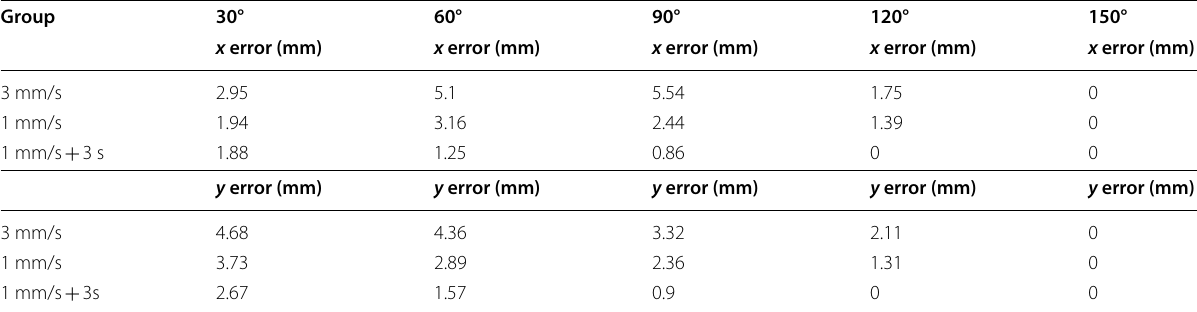
Table 3 The error of the corners in x and y direction